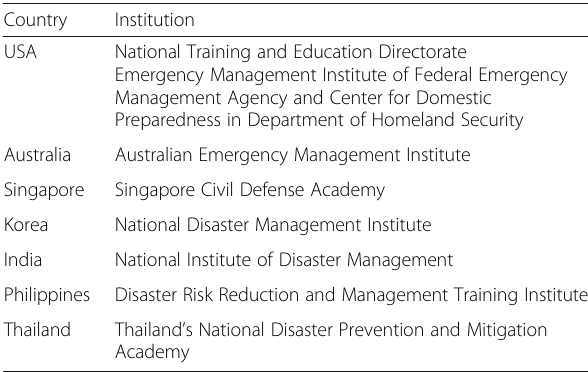
Table 4 Government institutions for the disaster management